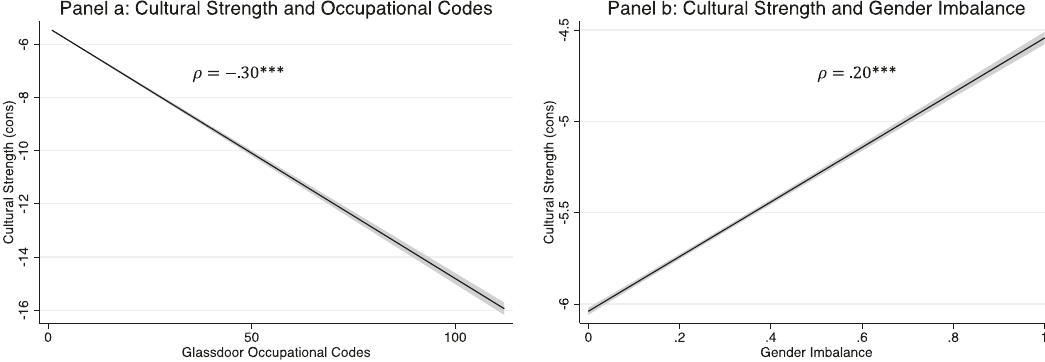
Fig. 7 Exploratory analysis of additional covariates of cultural strength (computed on “ cons ” ). In Fig. 7, we report results from bivariate analysis showing the correlation of cultural strength with variables selected for exploratory purposes. + p < 0.1; * p < 0.05; ** p < 0.01; *** p < 0.001.